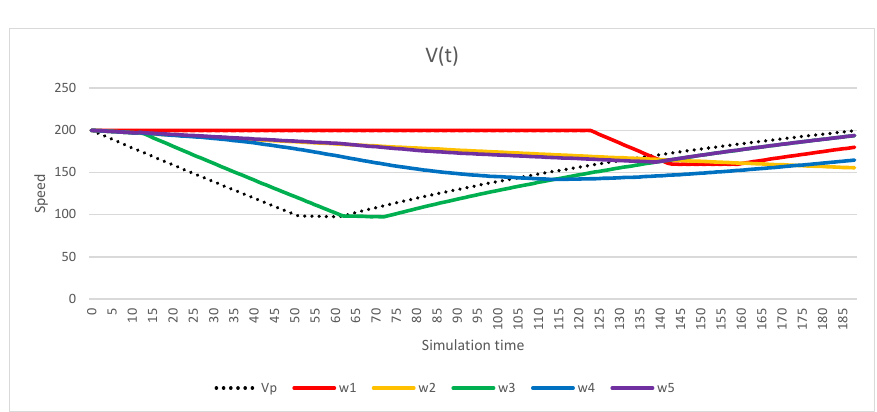
Figure 9. Velocity change V(t) in simulation by context 2 for distance D 0 = D gr = 4000 m.